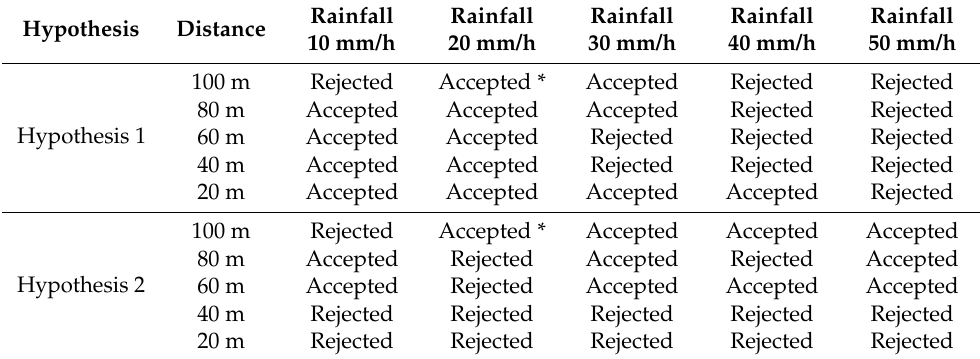
Table 6. Results of ANOVA test on the effect of the target material and speed on the NPC for each distance in the presence of